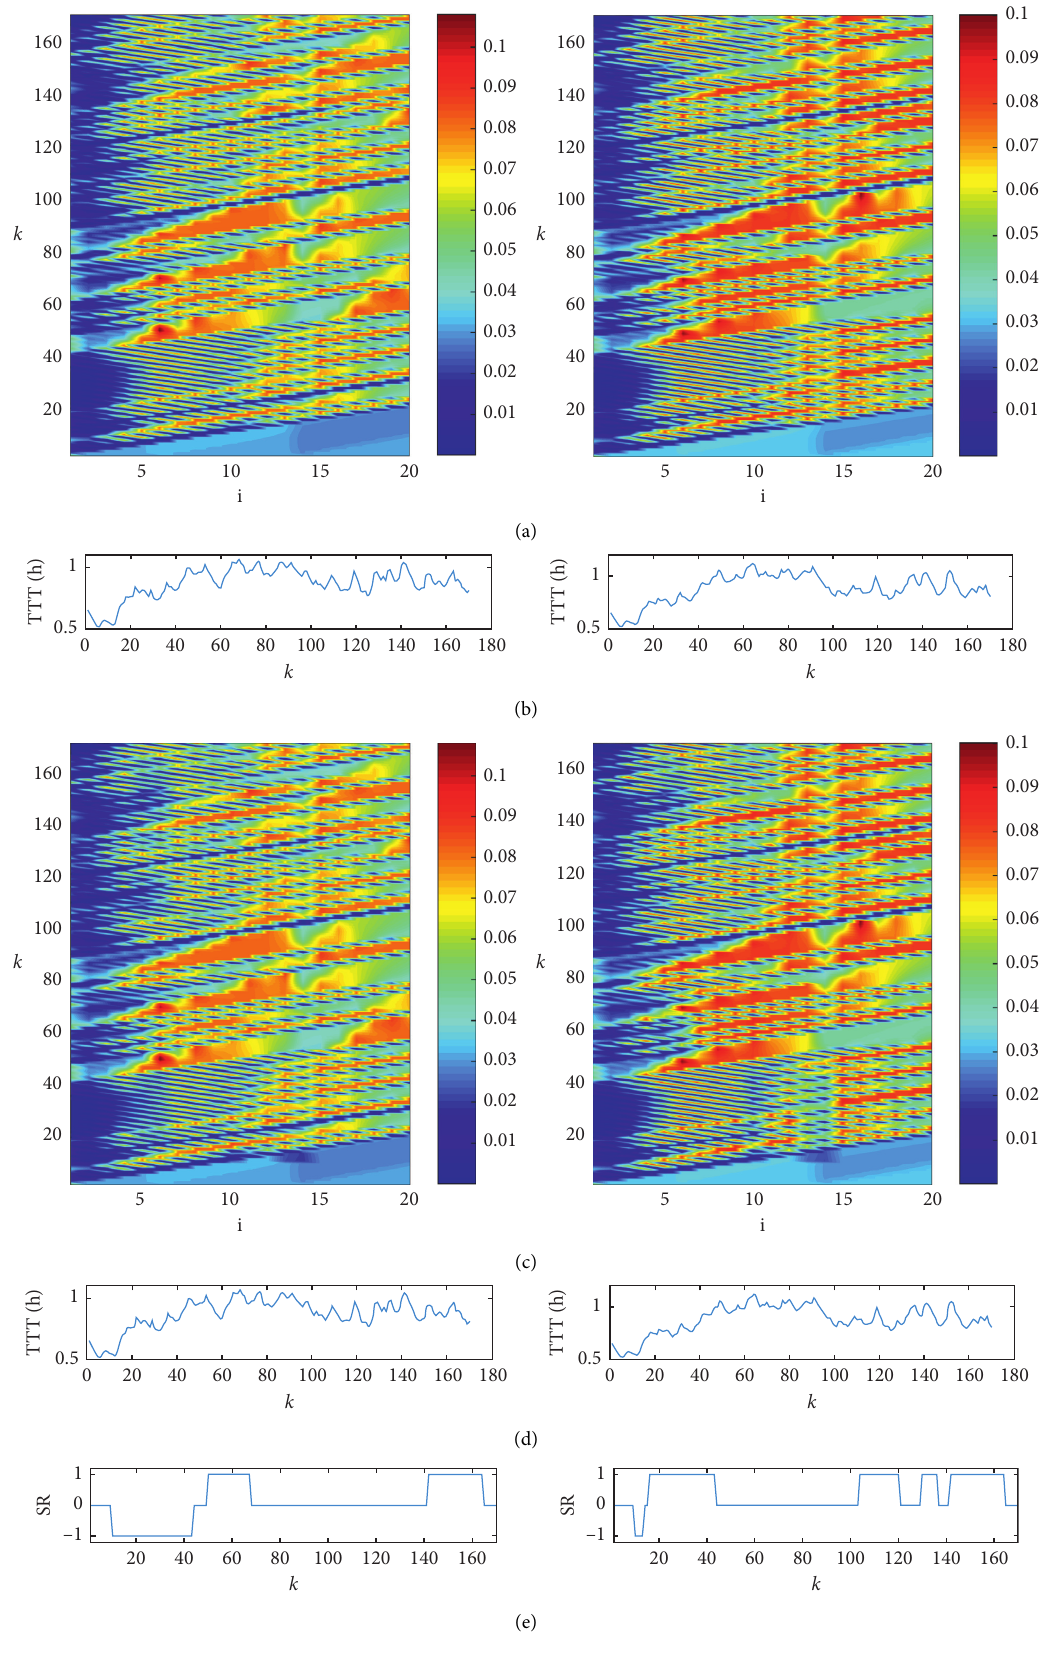
Figure 8: Results of case